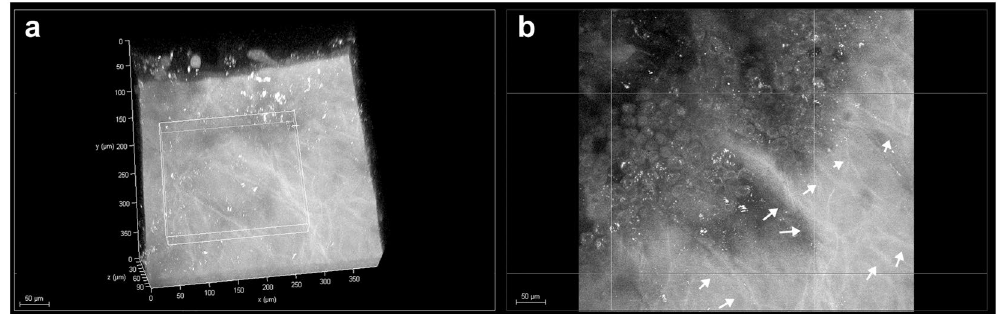
Figure 2. Basal nerve plexus in the hemicornea . ( a ) 3D reconstruction of the hemicornea (TPEF signal) showing the basal nerve plexus (scale bar 50 µ m). ( b ) The nerve fiber bundles (arrows) run parallel to each other forming thin branches that penetrate into the basal epithelial plane. The corneal epithelium is one of the most highly innervated structures in the human body; proper innervation is necessary for maintenance of normal corneal functions. There is strong evidence from laboratory studies that the nerve fibers provide trophic support to the corneal